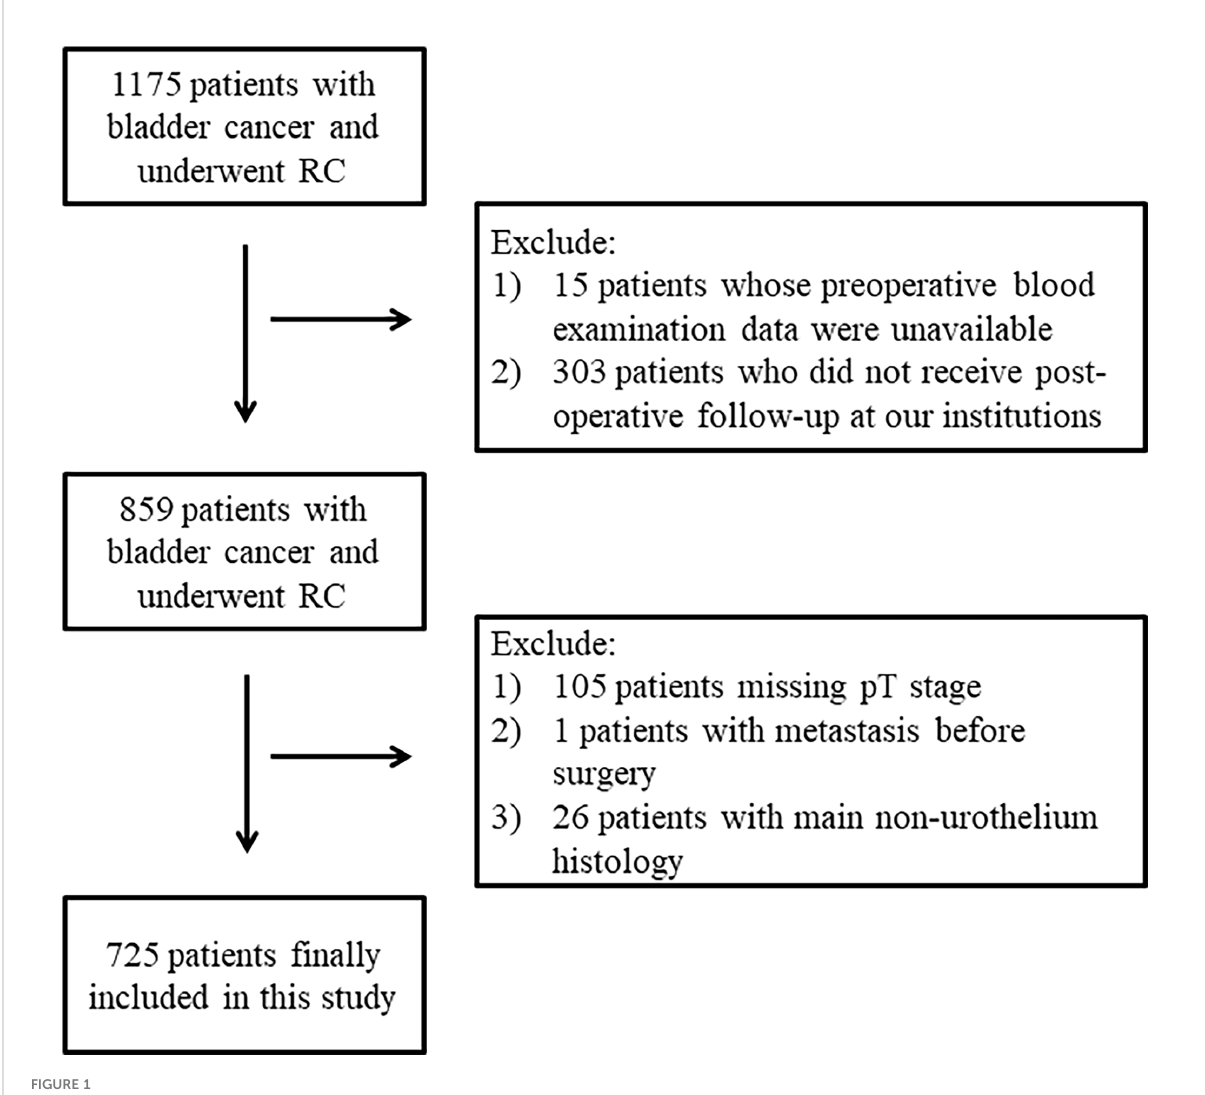
FIGURE 1 Flow diagram of included